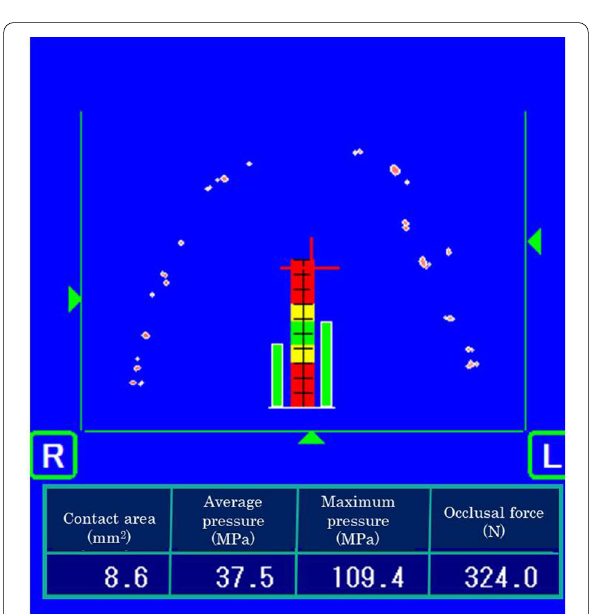
Fig. 1 Representative results of analysis of occlusal